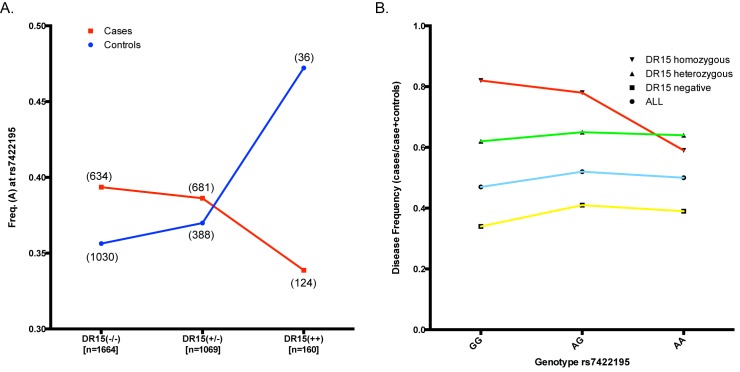
Discordant effect of rs7422195 in the presence or absence of HLA-DRB1*15:01.All samples (n = 3000) were first stratified according to the number of DR15 alleles then by genotype at rs7422195. (A) The frequency of the A-allele of rs7422195 was calculated for cases and controls within each DR15 genotype group, showing a clear decrease in the frequency of the A-allele with increasing copies of DR15 within MS cases, and the opposite effect in healthy controls. The total number of samples within each DR15 genotype group is included below the group name on the x-axis, with the number of individuals used to calculate each point represented in brackets on the graph. (B) Disease frequency for each group was calculated as the number of MS cases divided by the total number of cases and healthy controls for each genotype. The minor allele at rs7422195 shows an increase in the disease risk in the absence of DR15, but a clear decrease in the disease frequency amongst individuals carrying two copies of DR15.